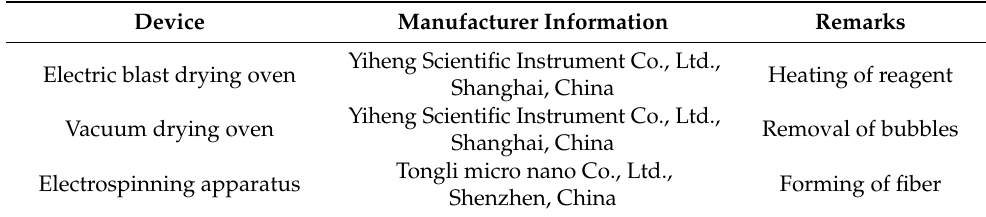
Table 2. The main